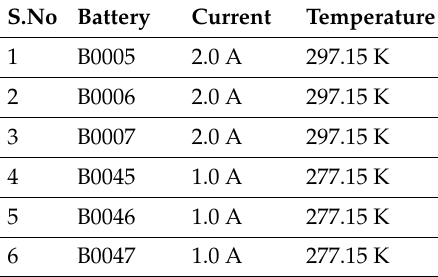
Table 1. Batteries with their current and temperature